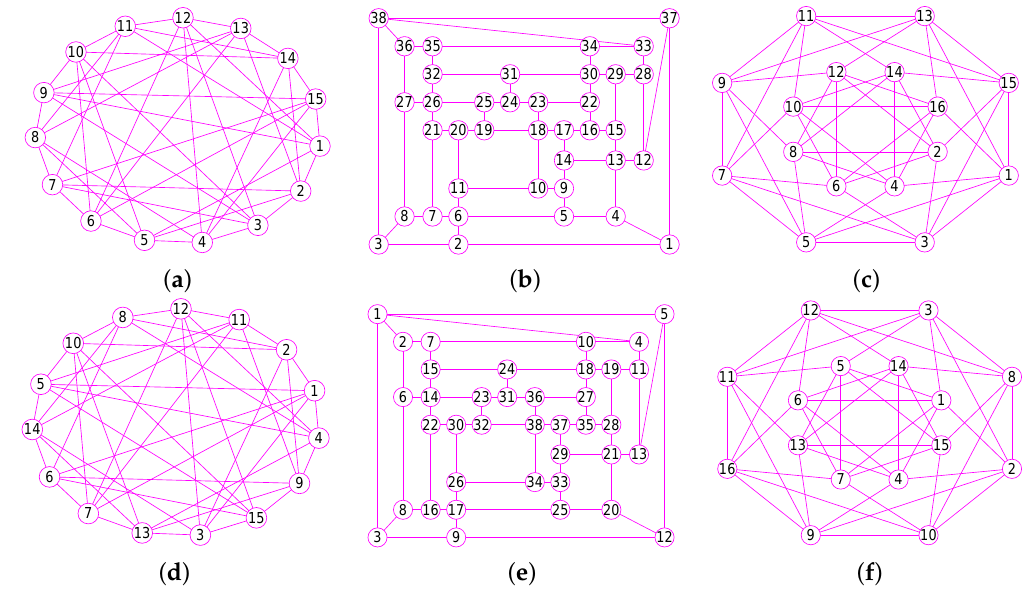
Figure 19. The TopMost graphs of three graphs G 28 , G 29 and G 30 . ( a ) A generalized quadrangle graph G 28 with 15 nodes and 45 edges; ( b ) A pentagonal icositetrahedral graph G 29 with 38 nodes and 60 edges; ( c ) A Shrikhande graph G 30 of 16 nodes and 48 edges; ( d ) The TopMost graph of G 28 ; ( e ) The TopMost graph of G 29 ; ( f ) The TopMost graph of G 30 .